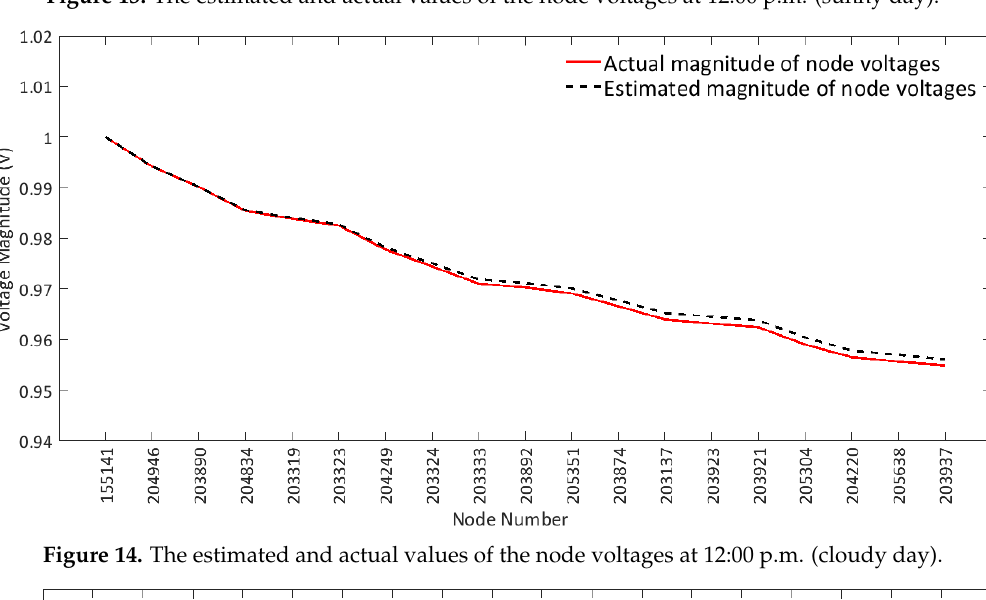
Figure 13. The estimated and actual values of the node voltages at 12:00 p.m. (sunny day).